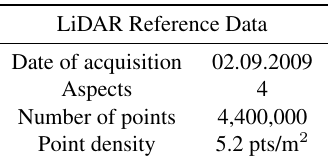
Figure 3. The IMBLS search window (green) and a classical, rectangularly-shaped search window (blue) around the candidate homologue point. (The red dots are the candidates corresponding to every h k .) Table 1. Parameters of the LiDAR reference data.